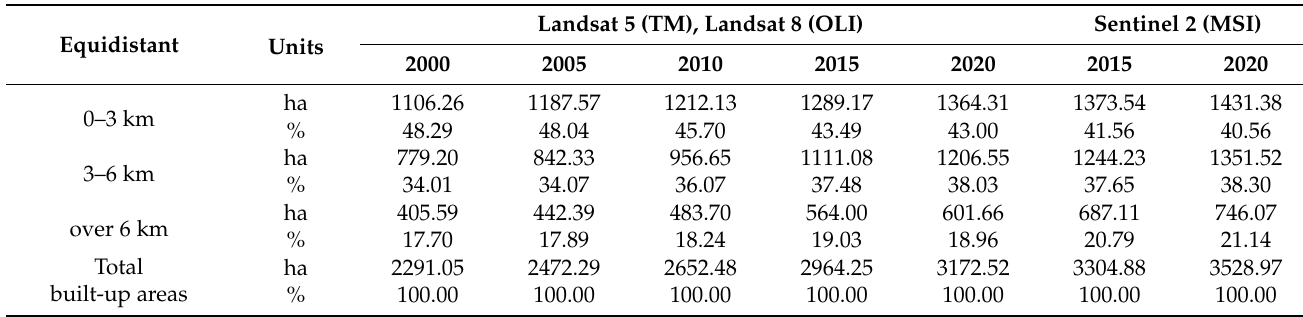
Table 4. Built-up areas in particular buffer zones from the centre of Opole obtained from processing of Landsat (2000, 2005, 2010, 2015, and 2020) and Sentinel (2015, 2020) satellite images, source: [84].